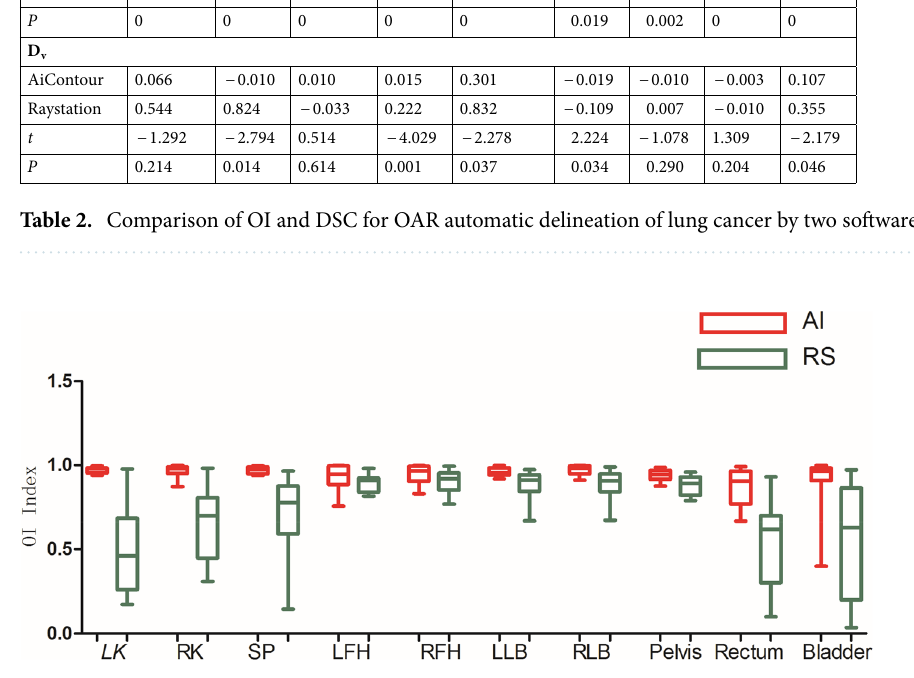
Figure 3. Comparison results of OI between two software in automatic delineation of rectal cancer OAR (Notation: LK means left kidney, RK means right kidney, SP means spinal cord, LFH means left femoral head, RFH means right femoral head, LLB means left leg bone, RLB means right leg bone).